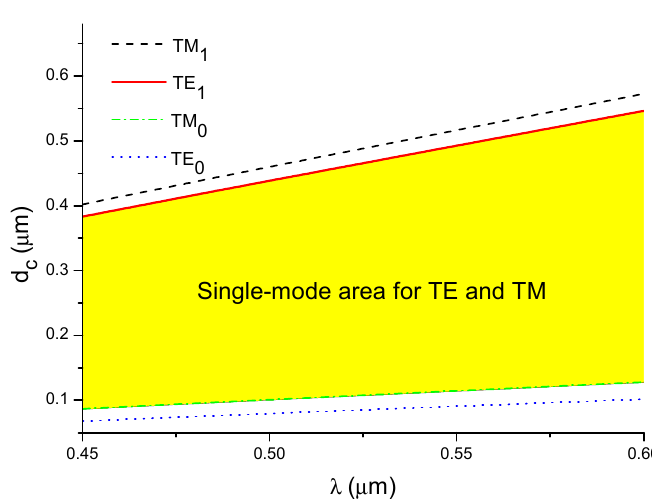
Figure 3. Dependence of the cut-off thickness on wavelength.